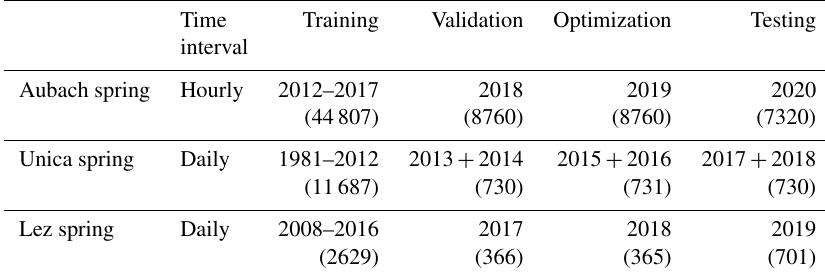
Table 1. Data splitting schemes for all study areas (number of values in parentheses).